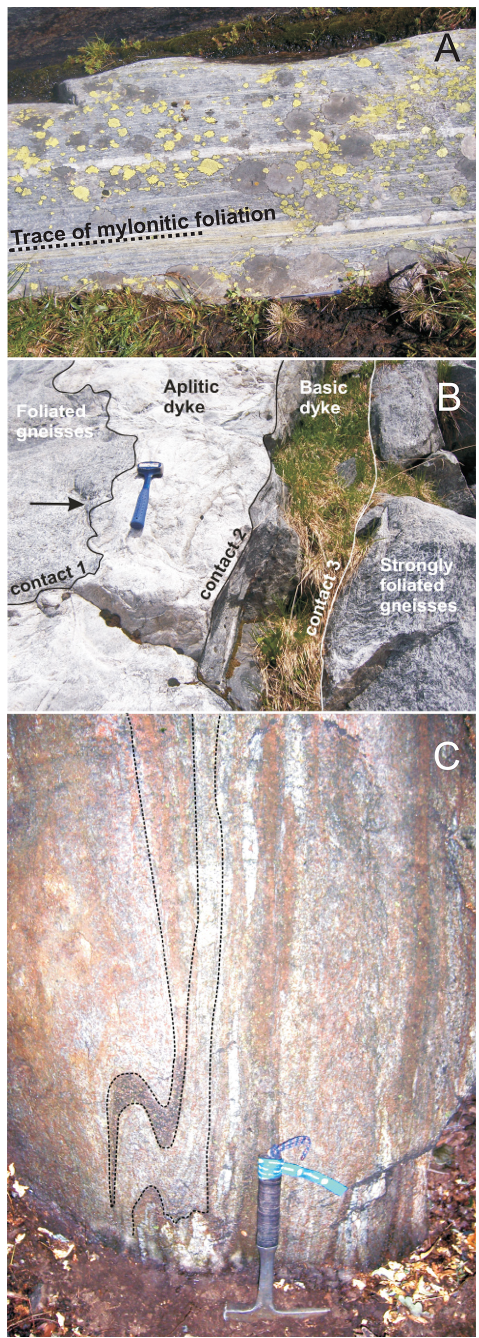
Figure 1. Outcrop photographs. (a) Shear zone 1 in orthogneiss with strong mylonitic foliation. (b) Shear zone 2 with two dykes de- veloped in granitic gneiss. Contact 1 shows a cuspate–lobate struc- ture (black arrow). (c) Shear zone 3, hosting strongly deformed and folded stronalite. Folds of compositional layering are highlighted by the dashed black